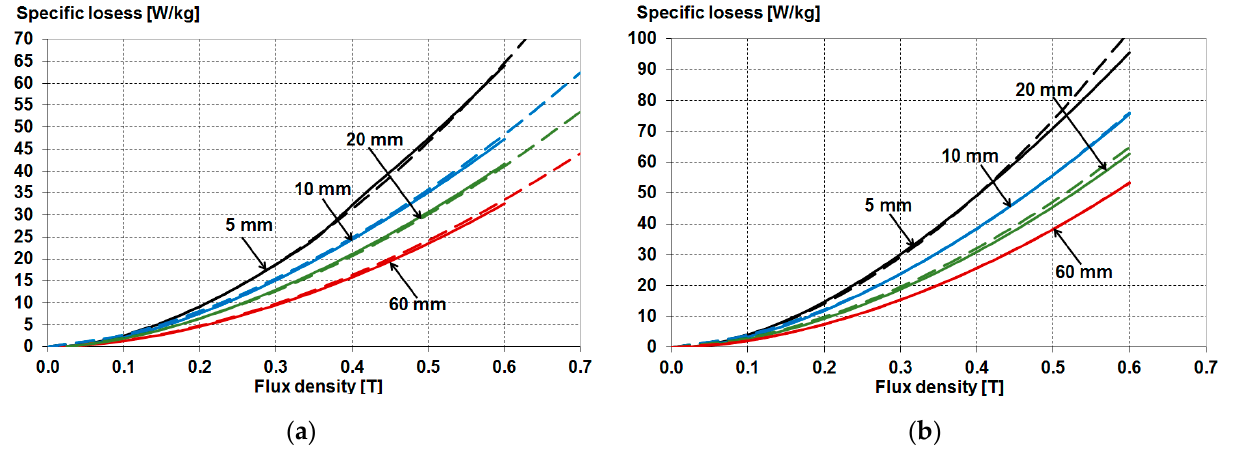
Figure 24. Measured and approximated loss characteristics of the M 270-35A sheet for various widths of the sheet samples at the frequency of 1000 Hz ( a ) and 1400 Hz ( b ) (measured—solid line, estimated—dashed line).